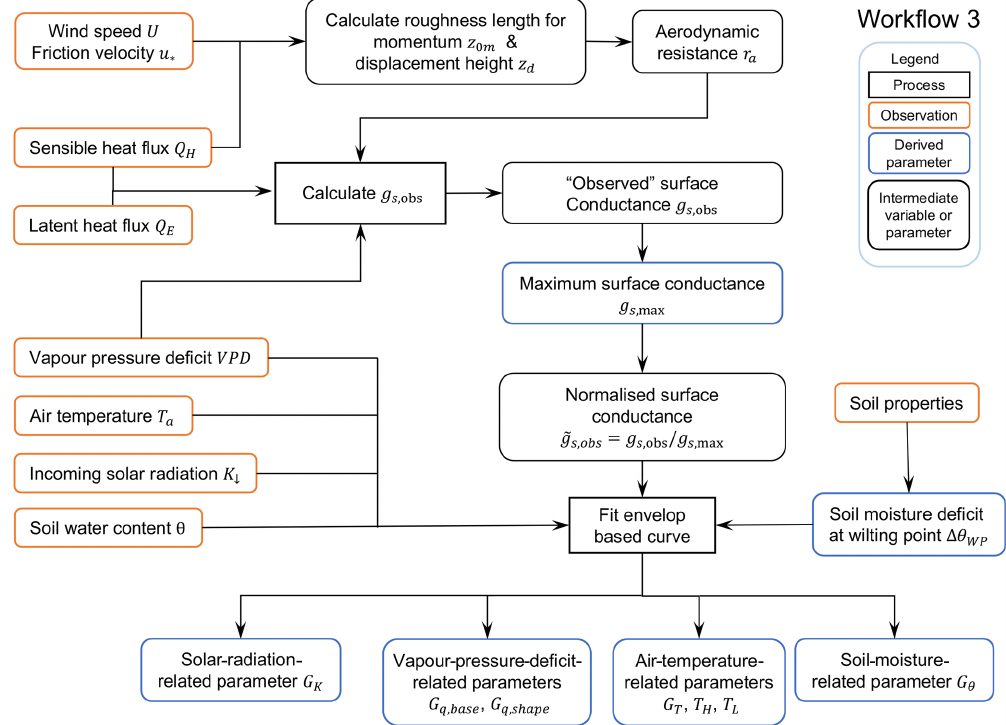
Figure 8. Workflow 3 (Fig. 1) for deriving surface-conductance-related parameters. Related notebooks are provided in Sun et al.